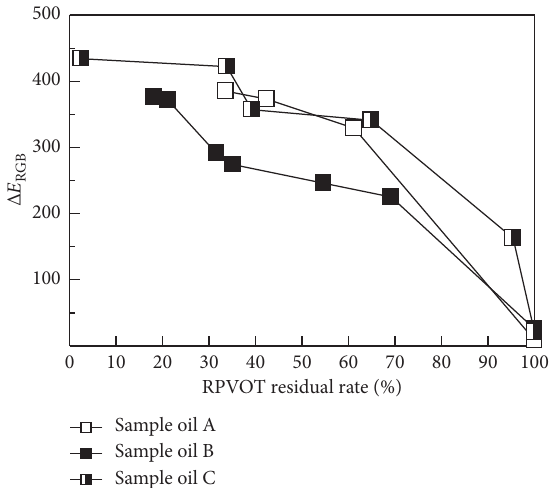
Figure 7: Relationship between RPVOT residual rate and Δ E